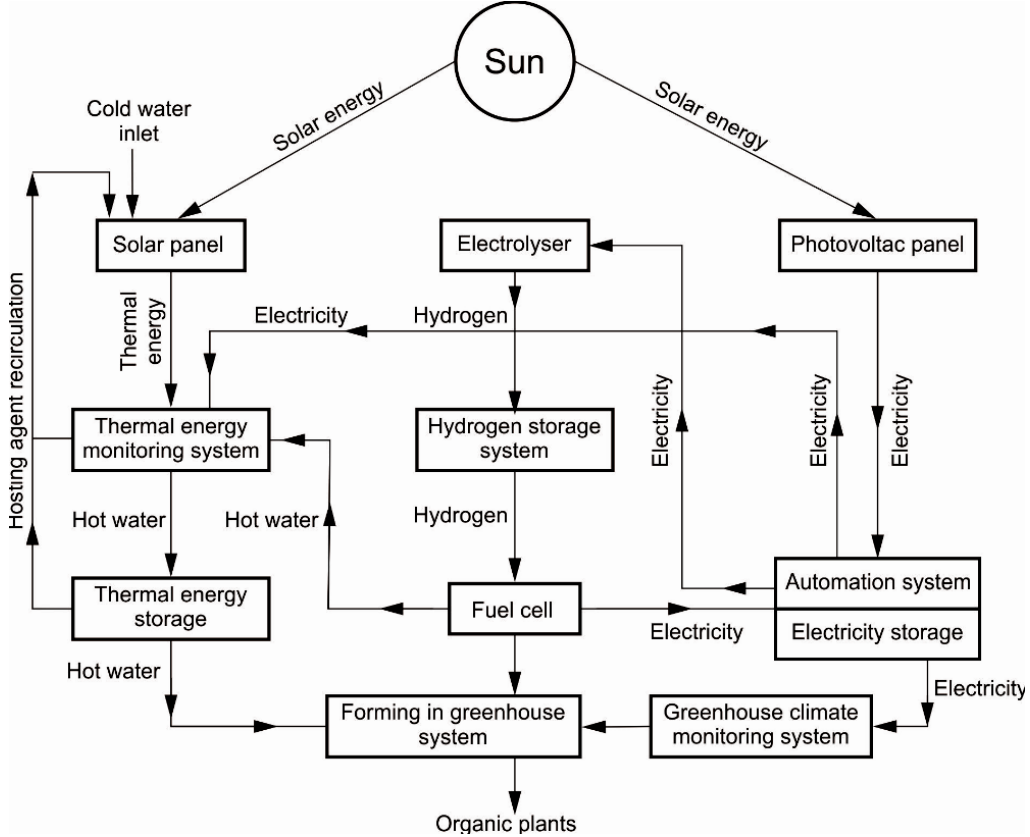
Figure 3. Schematic diagram of the hybrid greenhouse system.